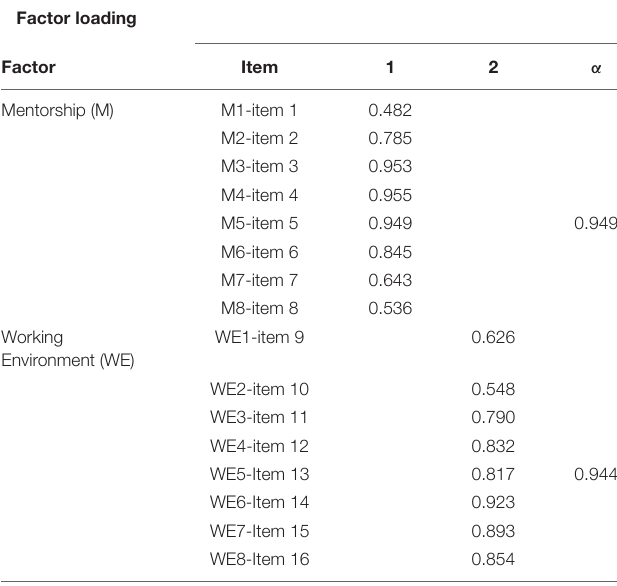
TABLE 2 | Factor loadings for exploratory factor analysis and internal reliability of the two institutional supports ( n =